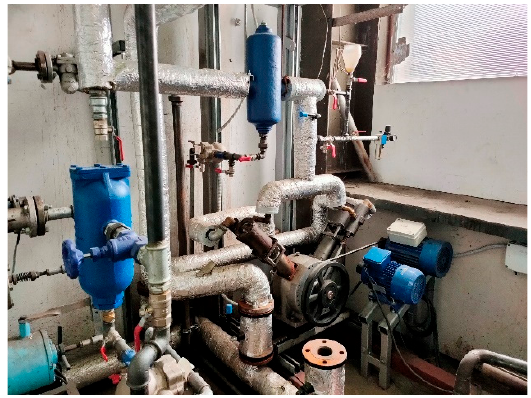
Figure 4. The steam engine and power generator used during the presented investigations. Energies 2020 , 13 , x FOR PEER REVIEW